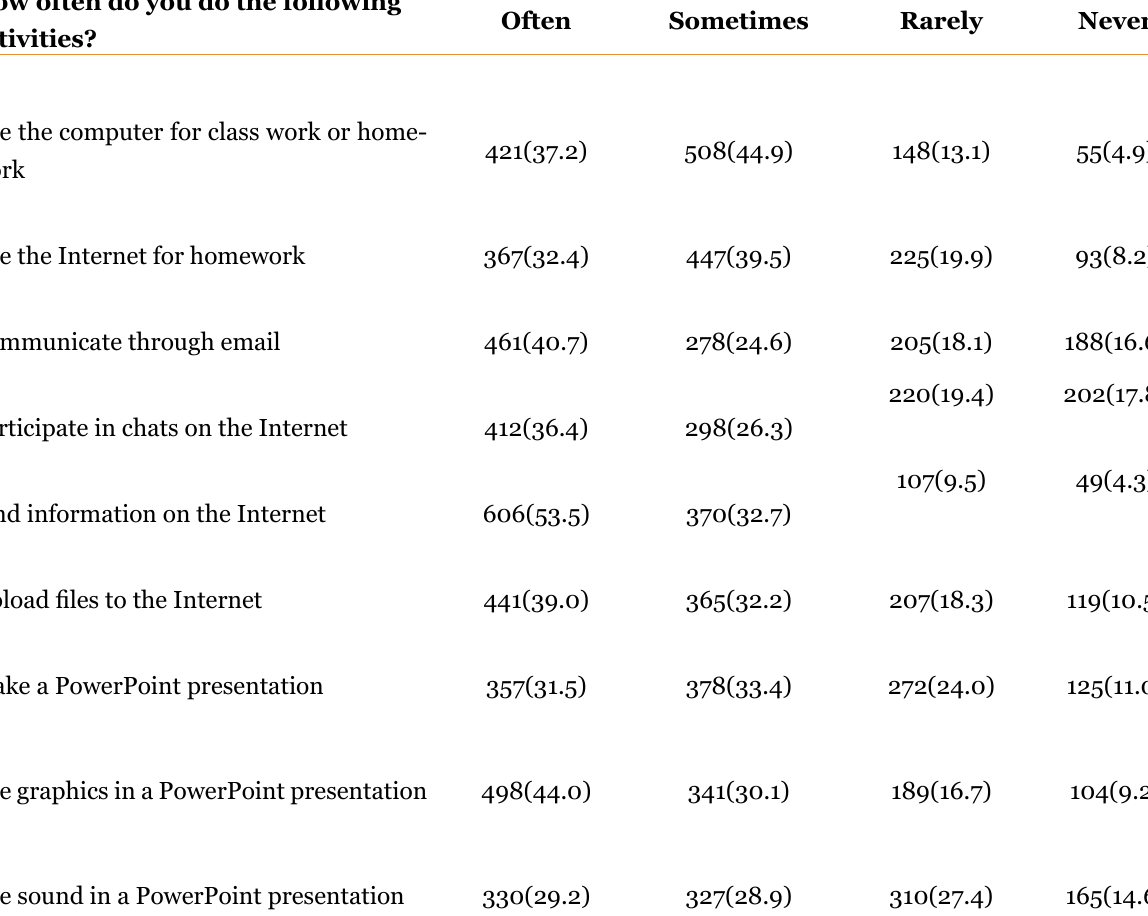
The Survey Questionnaire: Responses and